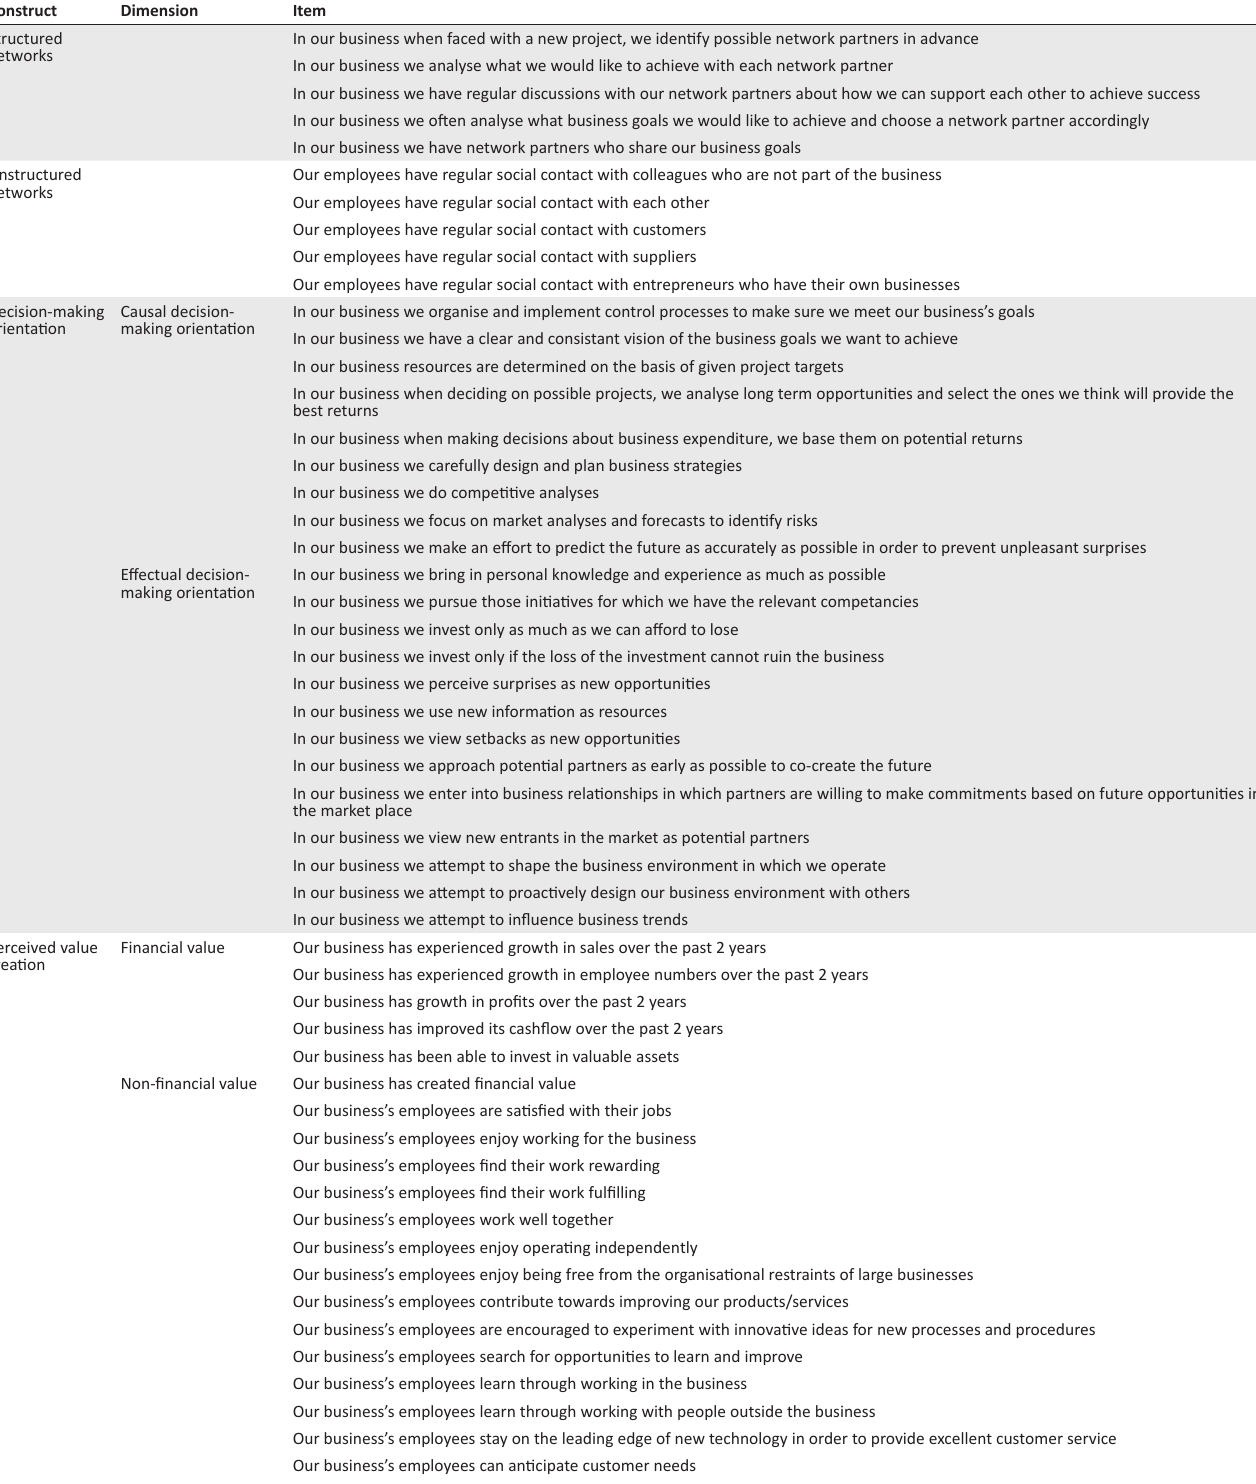
TABLE 1-A1: Scales and items questionnaire Construct Dimension Item Structured